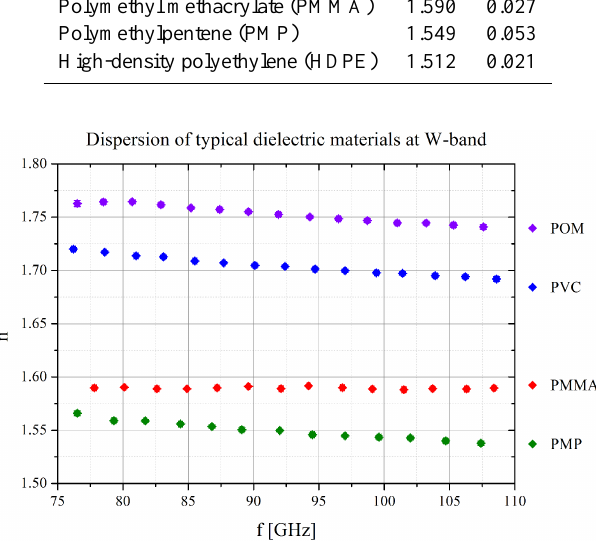
Figure 5. Dispersion of different plastics measured from single discs.